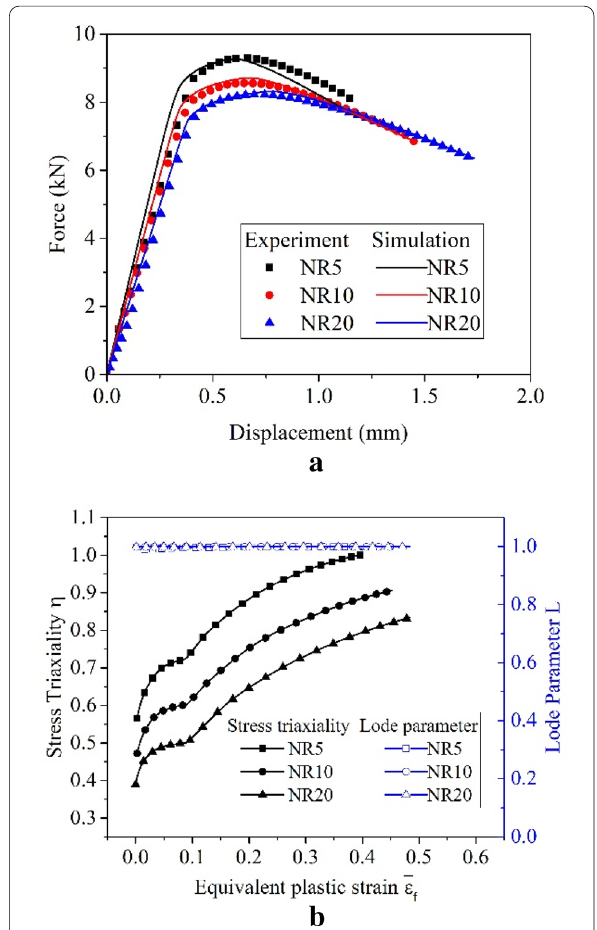
Figure 11 Tension tests of NR5, NR10, and NR20: a force– displacement response from experiments and simulation and ( b ) the evolution of ST and LP